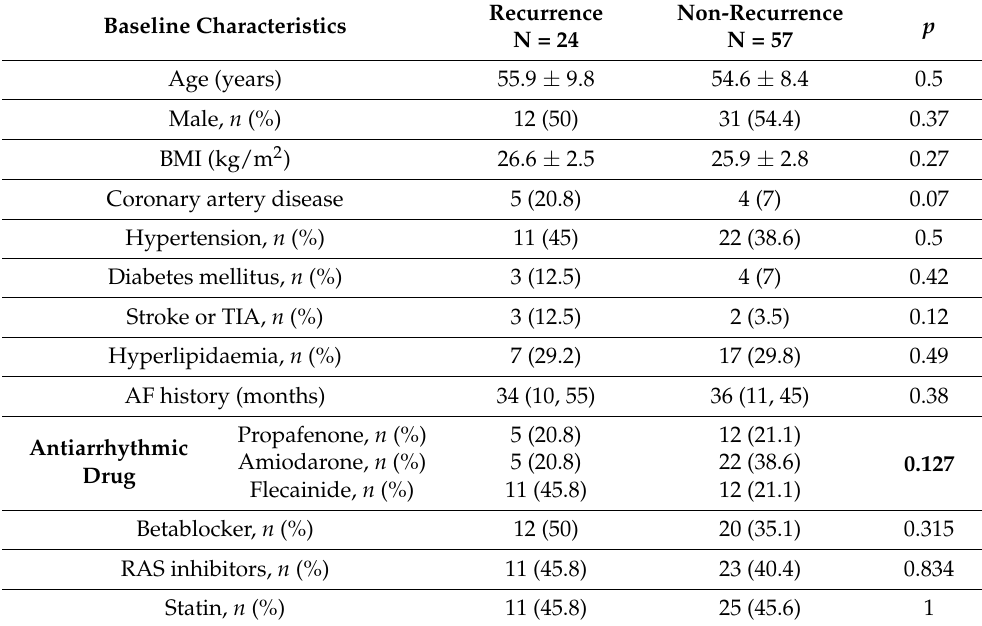
Table 1. Clinical characteristics after RFCA of AF.